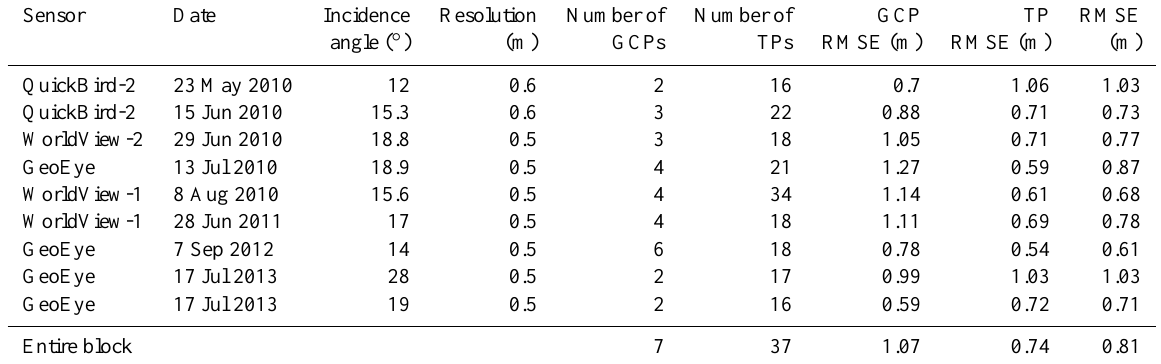
Table 1. List of very high resolution satellite imagery used for change detection and summary of multisensor bundle block adjustment.